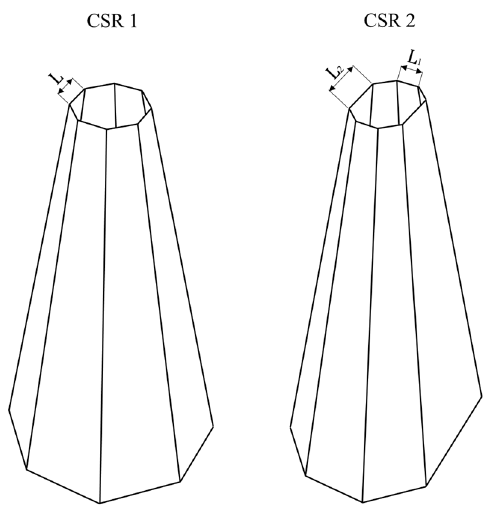
Figure 4. Tapered tubes design concept. Table 1. Panel geometrical parameters.